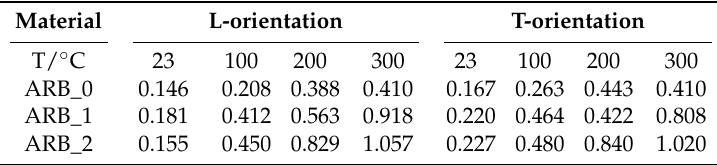
Table 2. Strain to fracture, ε f , estimated for both samples orientations and